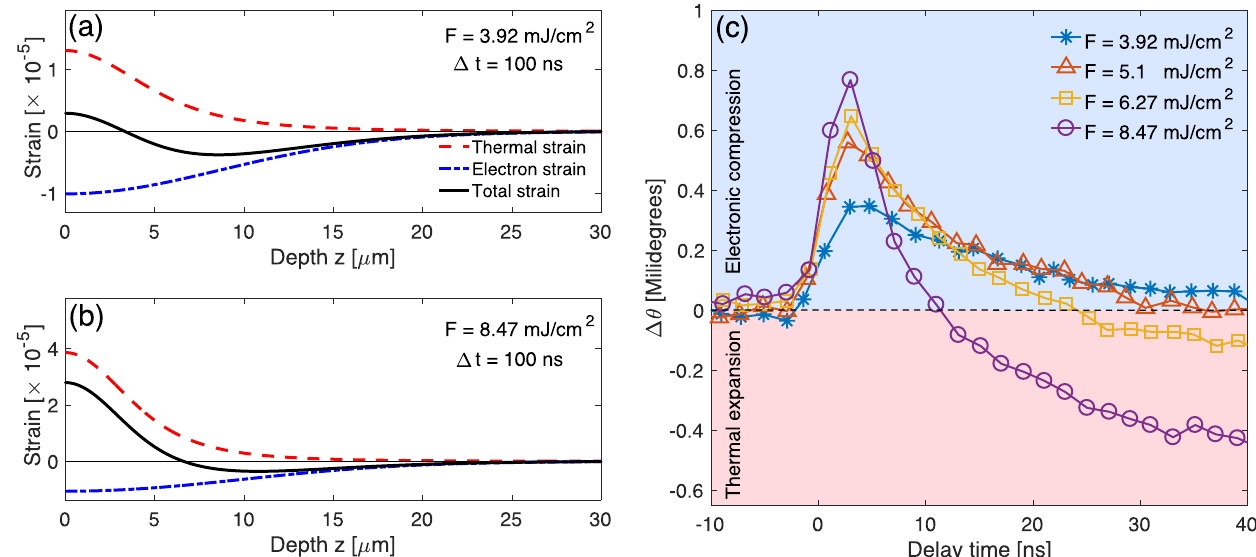
Figure 3. The distributions of the calculated thermal and electronic strains at ∆ t = 100 ns of F = 3.92 and 8.47 mJ/cm 2 in ( a , b ), respectively. ( c ) Centroid shifts of Bragg peaks at early delay time showing the competitions of electronic and thermal strains.